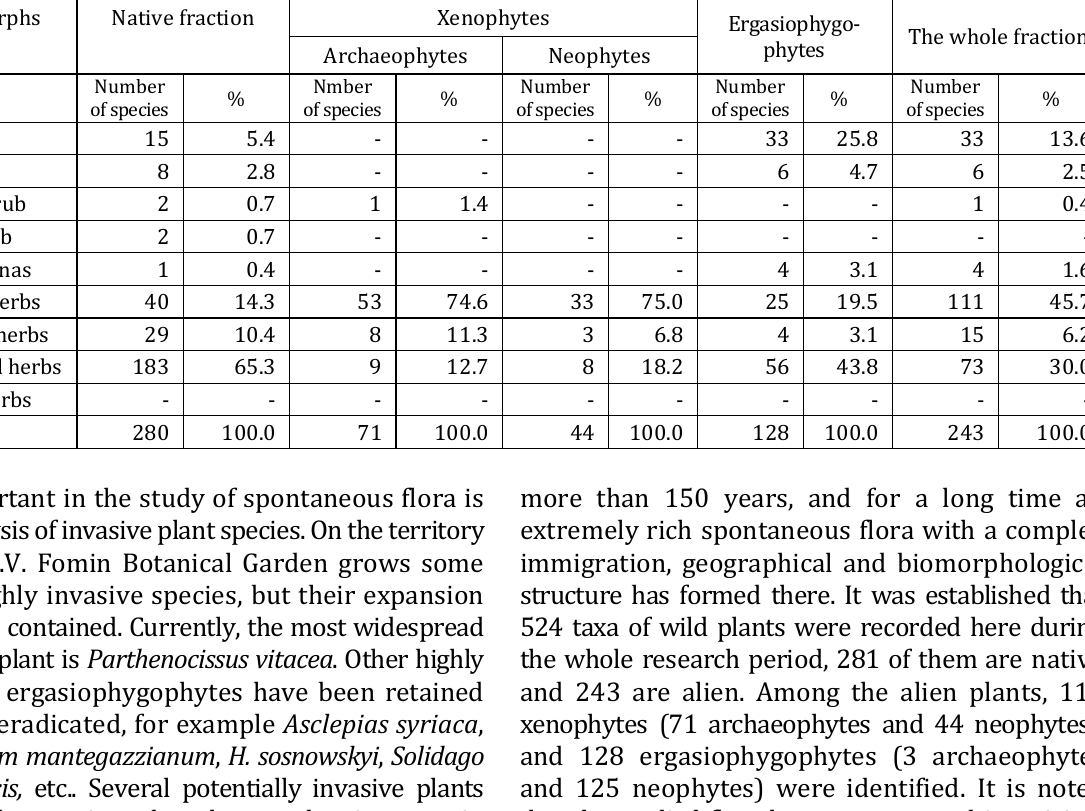
Table 6. Biomorphological structure of the spontaneous flora of the Botanical Garden